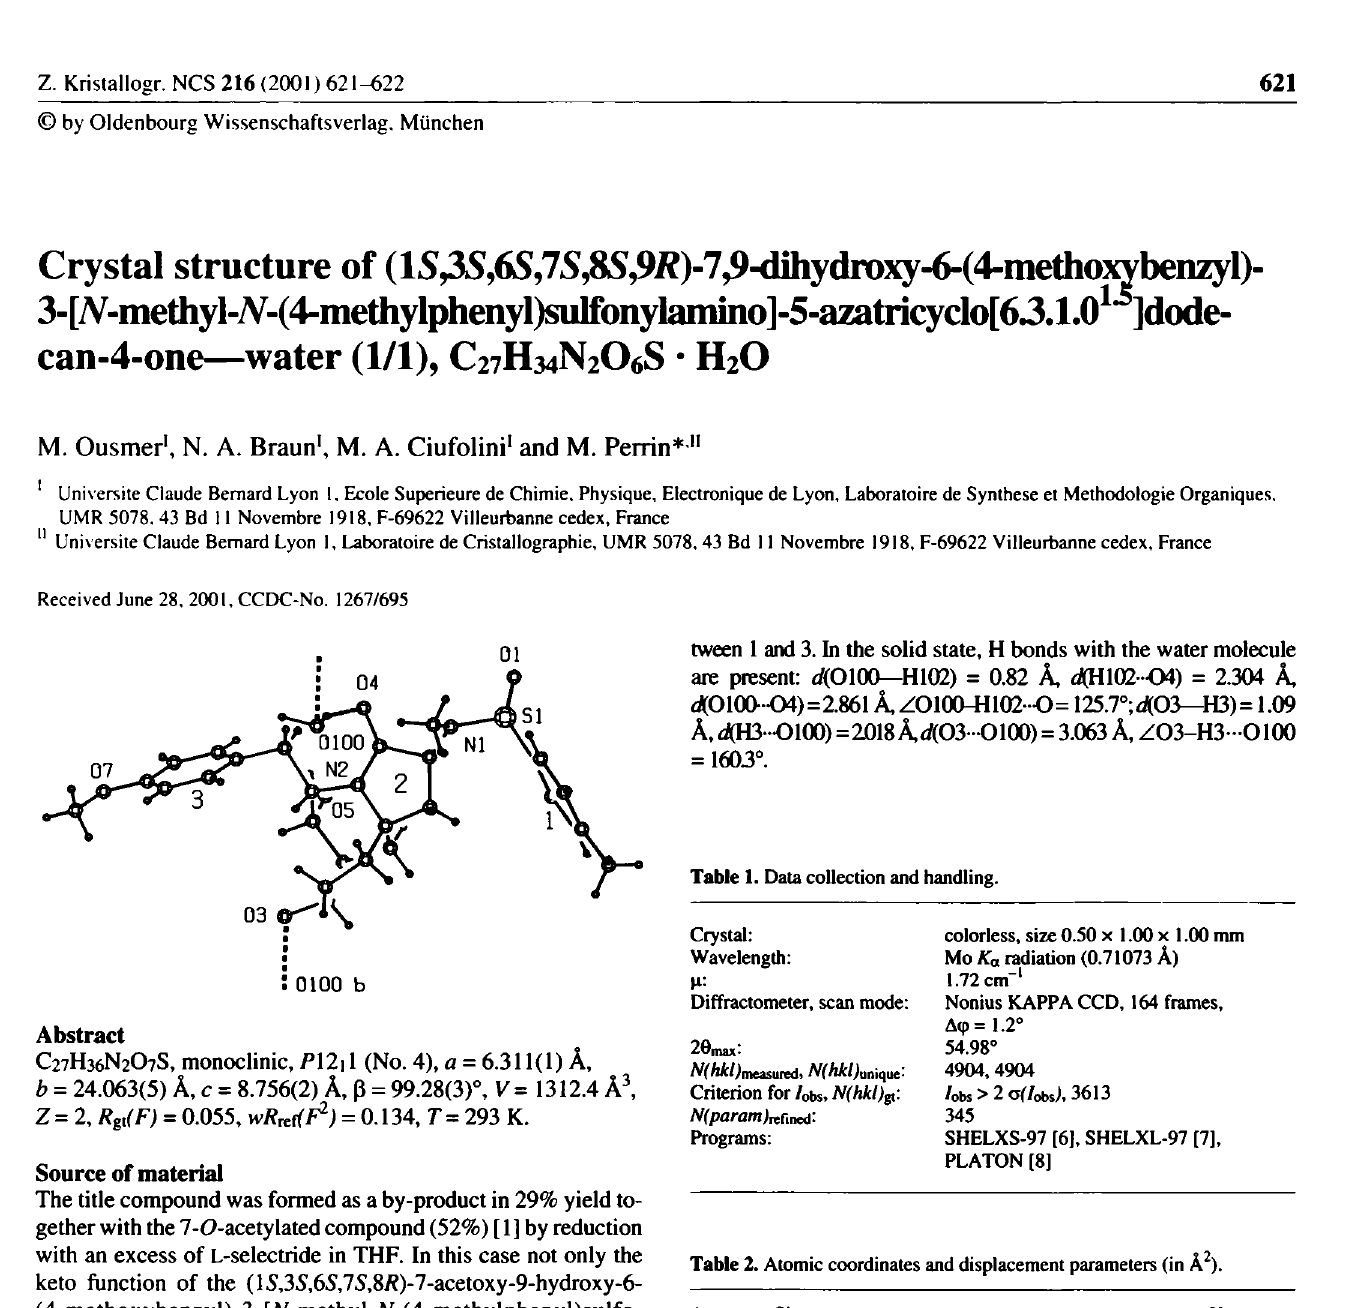
Table 2. Atomic coordinates and displacement parameters (in Ä 2